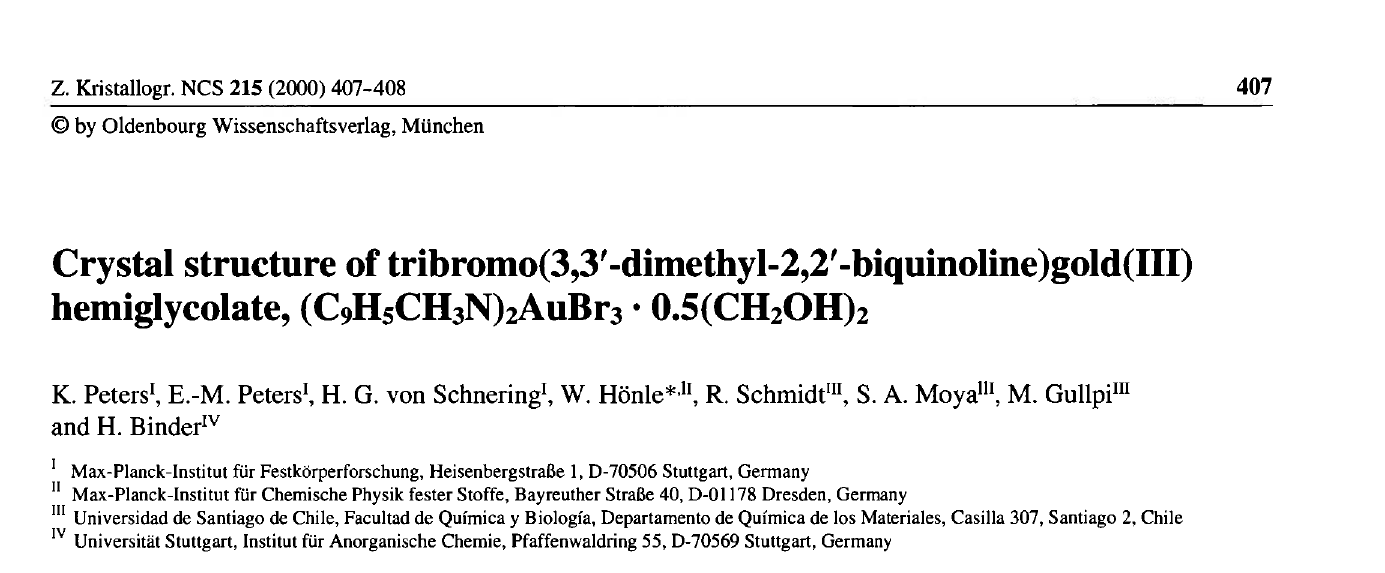
Table 1. Data collection and handling.